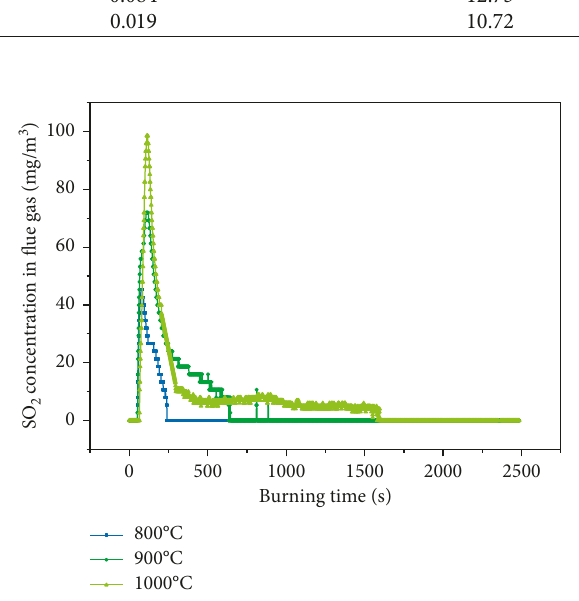
Figure 2: SO 2 emissions during combustion at different temperatures.